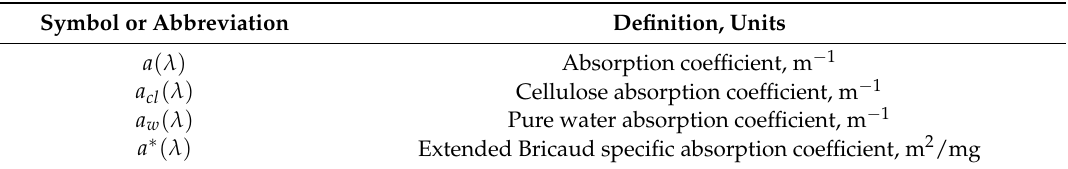
Table 1. List of abbreviations, symbols, definitions and